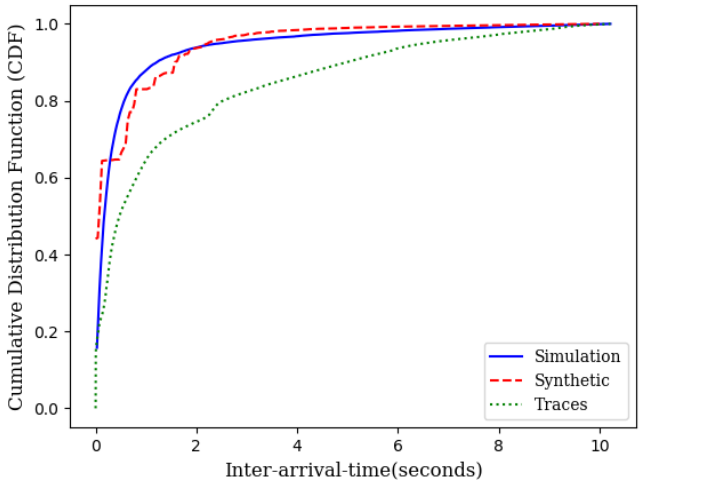
Figure 6. CDF of IoT traces, synthetic data, and the theoretical